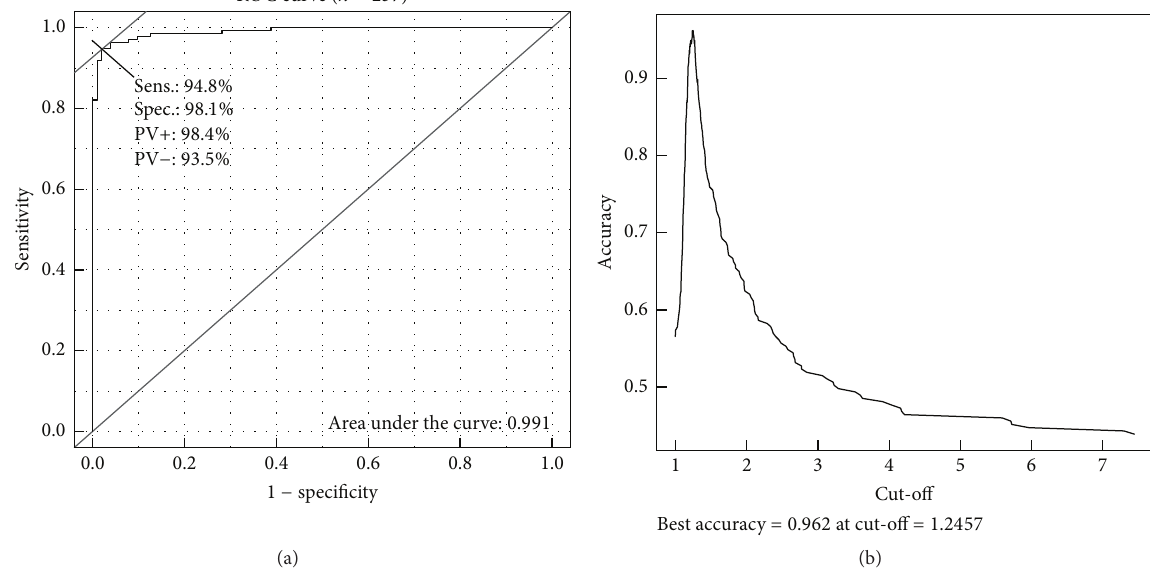
Figure 3: Cut-off determination for fluorescence index. (a) Receiver operating characteristic (ROC) of ANA screening with algorithm evaluation. Sens.: sensitivity, Spec.: specificity, PV+: positive predictive value, and PV − : negative predictive value. (b) Accuracy as a function of fluorescence index cut-off. Accuracy is the ratio between the number of correct prediction with algorithm and the total number of patients. Here the calculated cut-off is